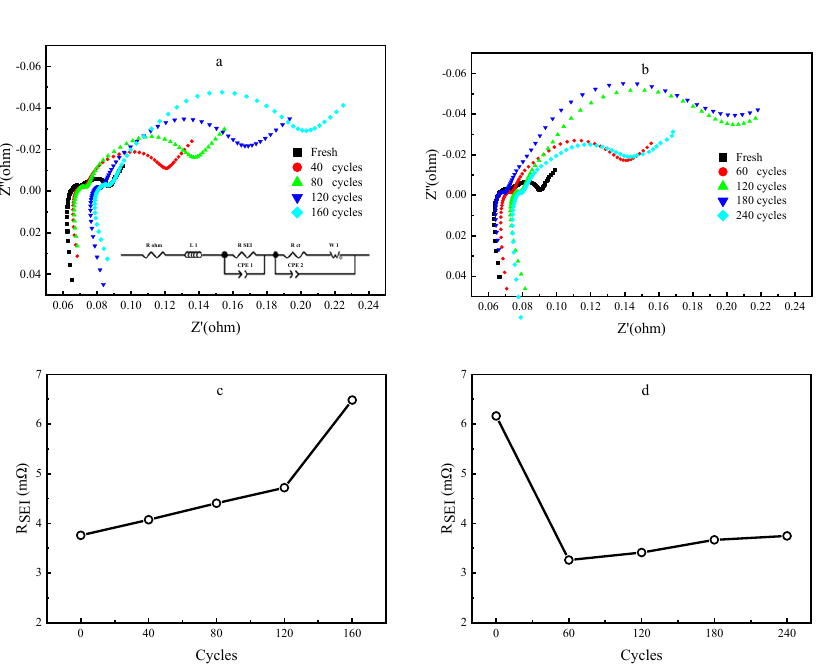
Fig. 5. The electrochemical impedance spectroscopy at different cycles of battery #1 (a), and battery #3 (b). The RSEI curve of battery #1 (c), and battery